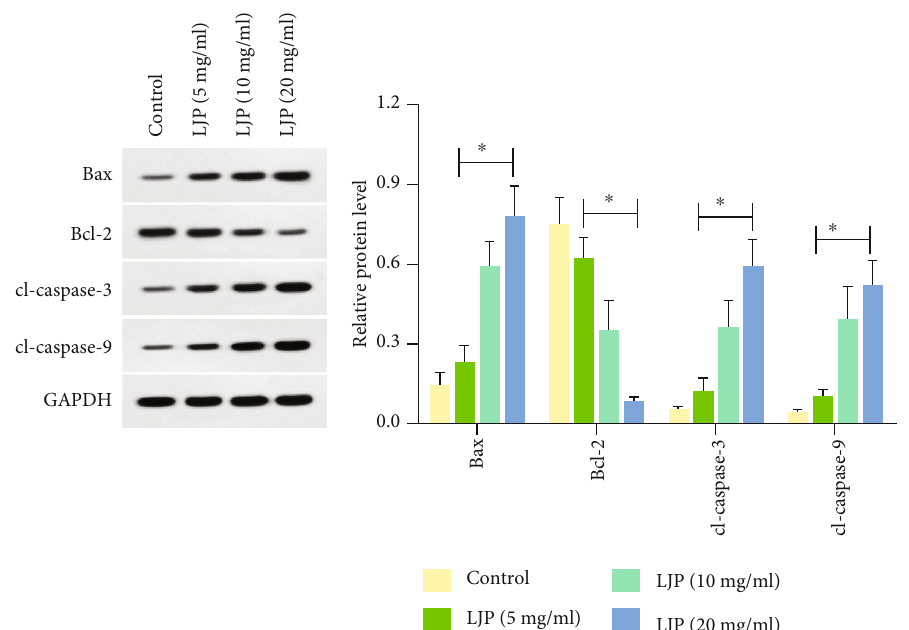
Figure 5: Expression of apoptosis-related proteins. ∗ P < 0 : 05 versus control group. Western blot assay was used to detect expression of apoptosis-related proteins after treated with di ff erent concentrations of LJP for 24